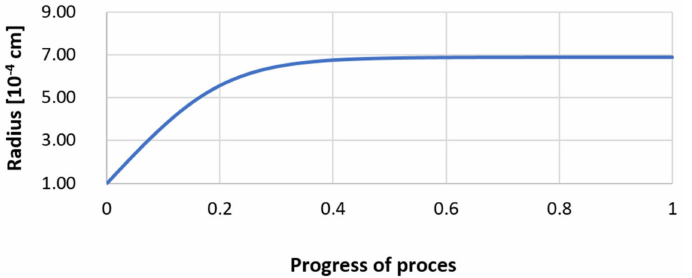
Figure 26. Growth of the radius of nucleus (with an initial radius r 0 = 1 µ m) in steel 3.